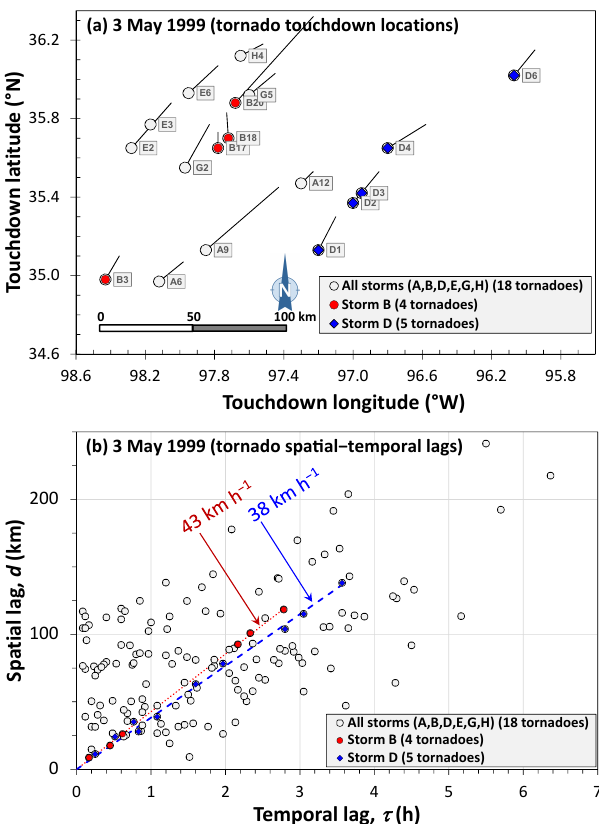
Figure 7. Five model tornado touchdown points located randomly in time during a 6h time window along a linear track. (a) The touch- down positions x along the track are shown as a function of the random times t of occurrence. The model supercell thunderstorm responsible for the tornadoes moves along the track at a velocity v = 80kmh − 1 . (b) Spatial–temporal lag correlations between the 5 model tornadoes shown in Fig. 7a. The spatial lag d is plotted against the temporal lag τ for each of the 10 pairs of model tornado touchdown points. The data points again lie on a straight line with a slope of 80kmh − 1